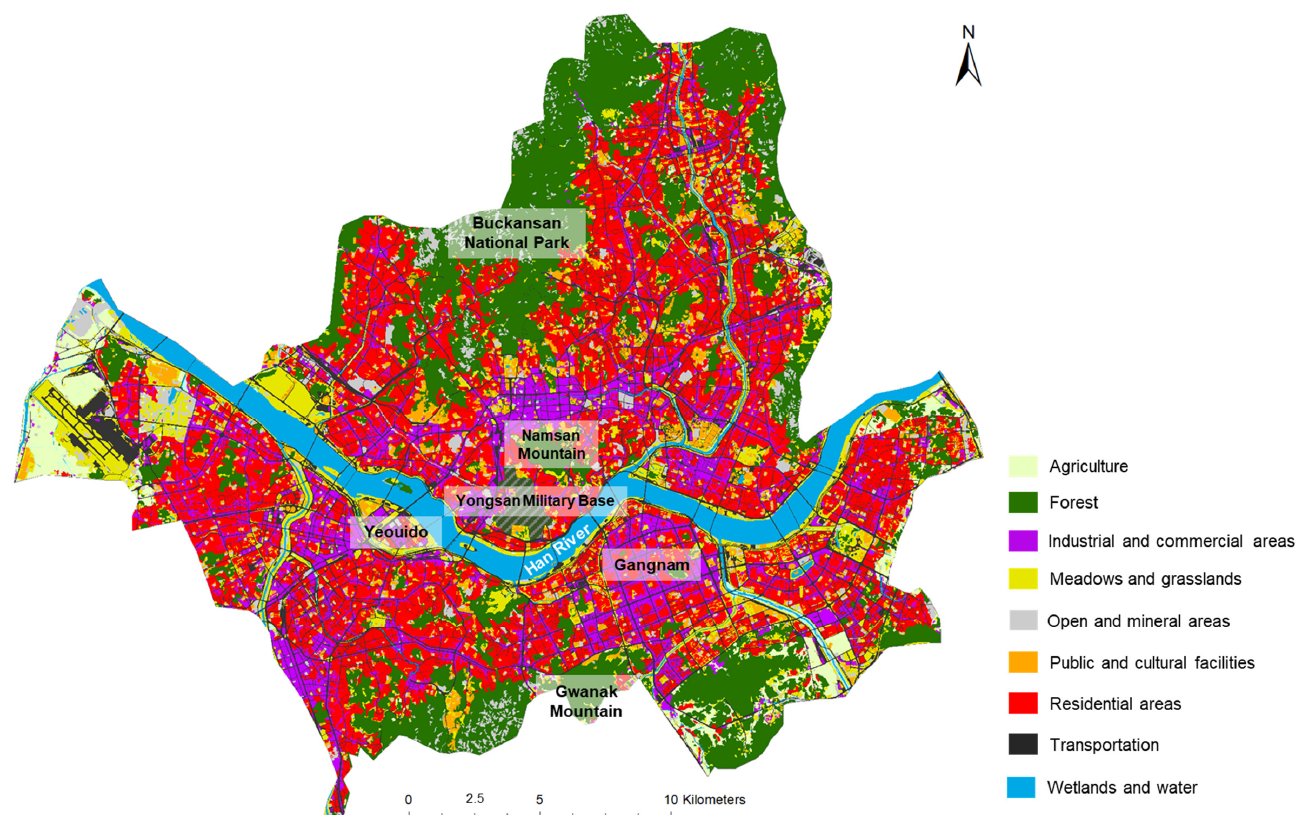
Figure 1. Land-use class of the city of Seoul (2017) and some major landmarks.